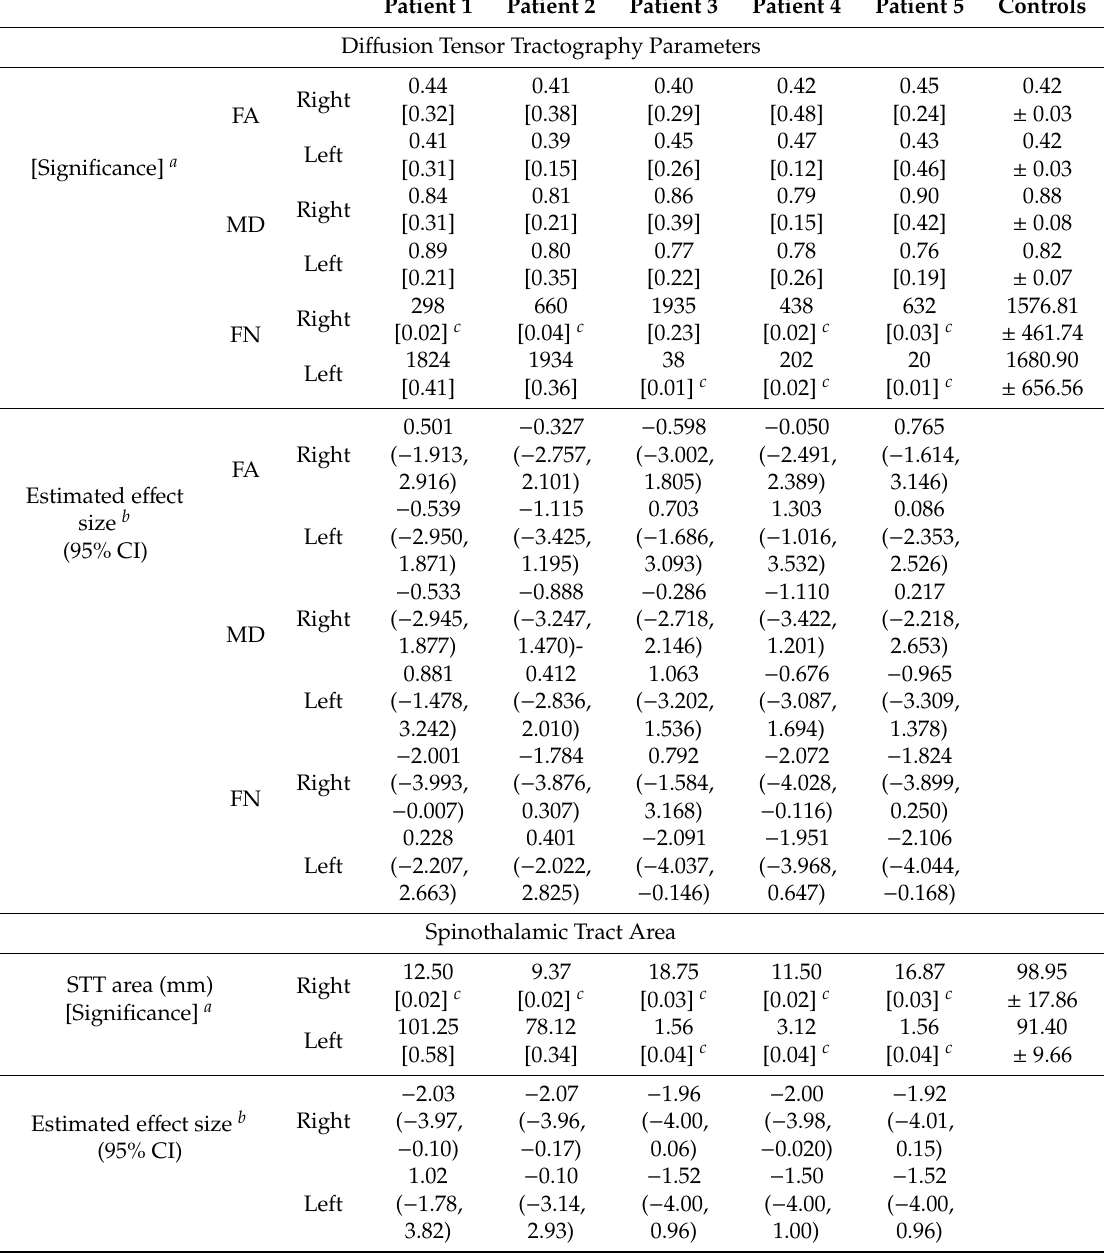
Table 2. Results of Bayesian statistics analyses of di ff usion tensor tractography parameters and spinothalamic tract (STT) areas of the individual patients and the group of control